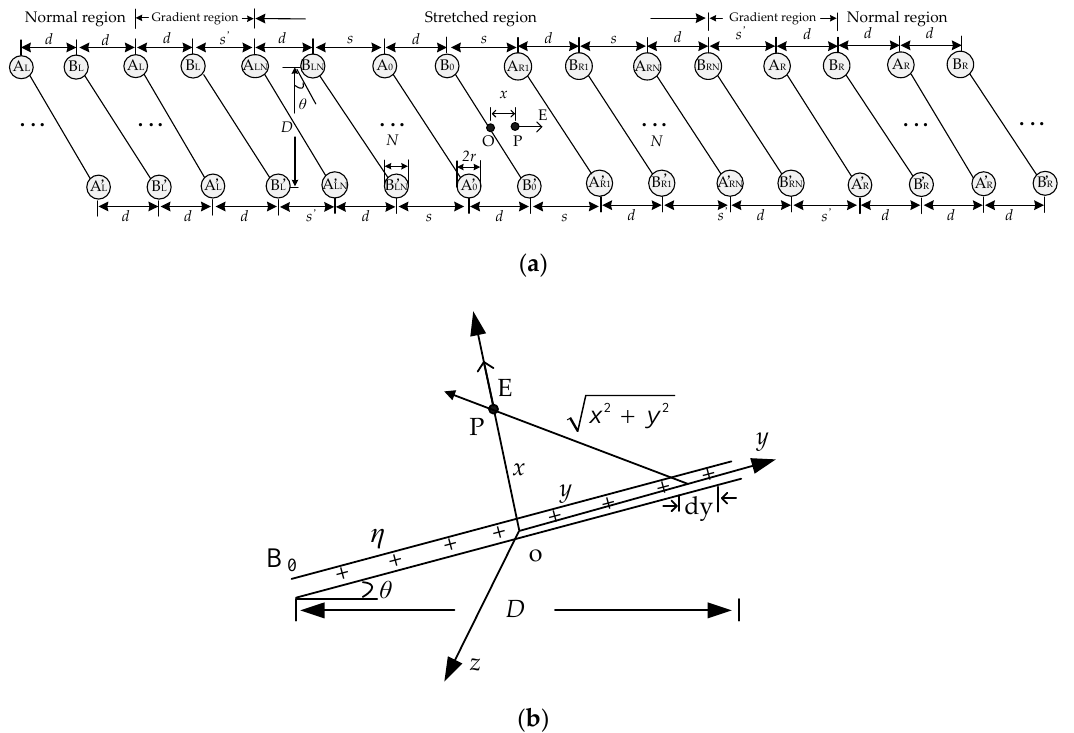
Figure 3. The cross-section model of the PHSC for the distributed parameters ( a ) cross-section model; ( b ) diagram of the electric field distribution.